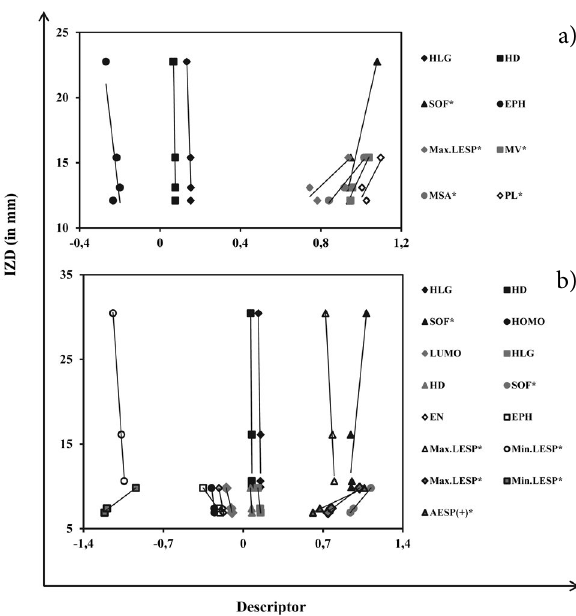
Figure 3. The correlation between descriptors and the IZD values of the ligands 4b , e – g and 4a , b , d – h against Gram-negative bacteria 1855 (a) and 1234 (b), respectively. Descriptors with large outlying numerical values (superscripted by *) are divided by them of ligand 4c for the charts to be able to cover all the numbers.